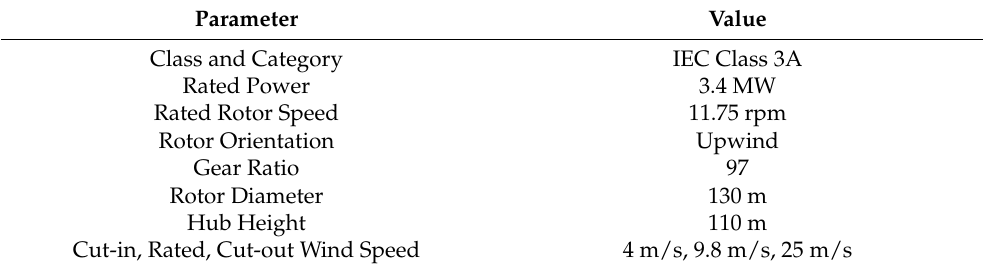
Table 1. Properties of IEA 3.4A turbine model.